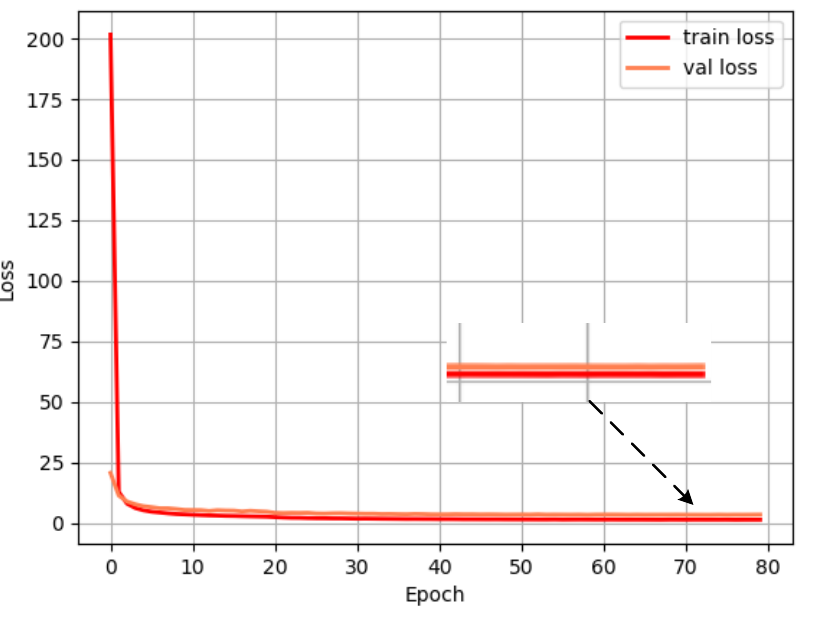
Figure 7. Loss convergence of